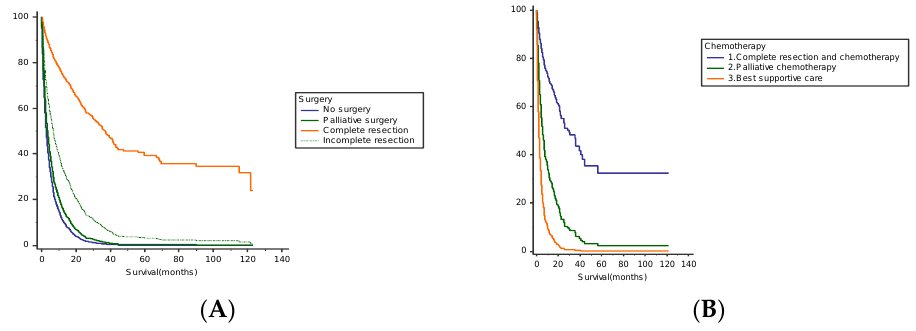
Figure 2. ( A ) Survival rates stratified by type of surgery (no surgery (median 2.45, 95% CI 2.16 to 2.80); palliative surgery (derivative stoma, internal bypass) (median 3.13, 95% CI 2.13 to 4.43); complete resection (complete resection of primary tumor and metastases) (median 36.40, 95% CI 18.16 to 123.06); Incomplete resection (incomplete resection of primary tumor and metastases) (median 7.32, 95% CI 6.38 to 8.80) Log-rank p < 0.0001). ( B ) Survival rates stratified by chemotherapy (complete resection of primary lesion and adjuvant chemotherapy (median 36.10, 95% CI 18.16 to 56.20); palliative chemotherapy (median 7.96, 95% CI 6.76 to 10.00); best supportive care (median 2.06, 95% CI 1.80 to 2.32) Log-rank p < 0.0001).